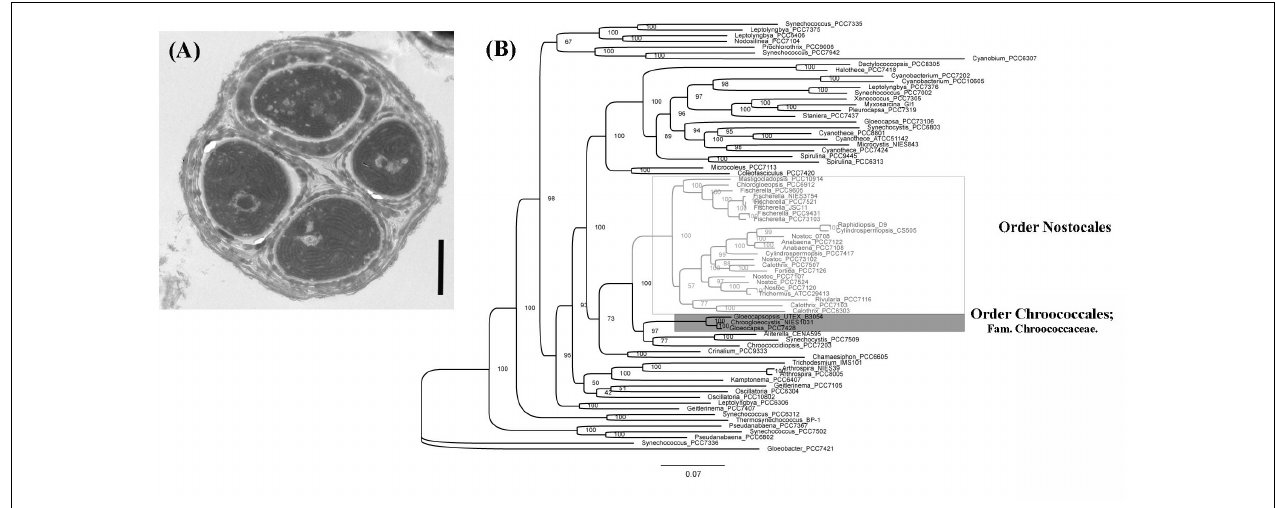
FIGURE 1 | (A) Transmission electron photomicrograph of a characteristic tetrad of the unicellular Gloeocapsopsis sp. UTEX B3054. Note the multilayered and abundant extracellular polymer substance surrounding cells. Scale bar: 1 µ m. (B) Phylogenomic tree generated by Maximum-likelihood using 43 cyanobacterial marker genes from 74 cyanobacterial genomes, based on the evolutionary substitution model LG + R8. Gloeobacter violaceus PCC7421 was used as outgroup. In gray box, the Chroococcaceae family (Order Chroococcales), which encompasses Gloeocapsopsis sp. UTEX B3054. This clade share ancestors with Chroococcidiopsis thermalis PCC7420, which has been assigned by Komárek et al. (2014) to the family Chroococcidiopsidaceae (order Chroococcidiopsidales). Few genomes of representatives of both clades have been successfully sequenced. Bootstrap values from phylogenetic analysis are displayed at the nodes. In white box, cyanobacterial representatives of section IV and section V. Both clades belong to the Nostocales